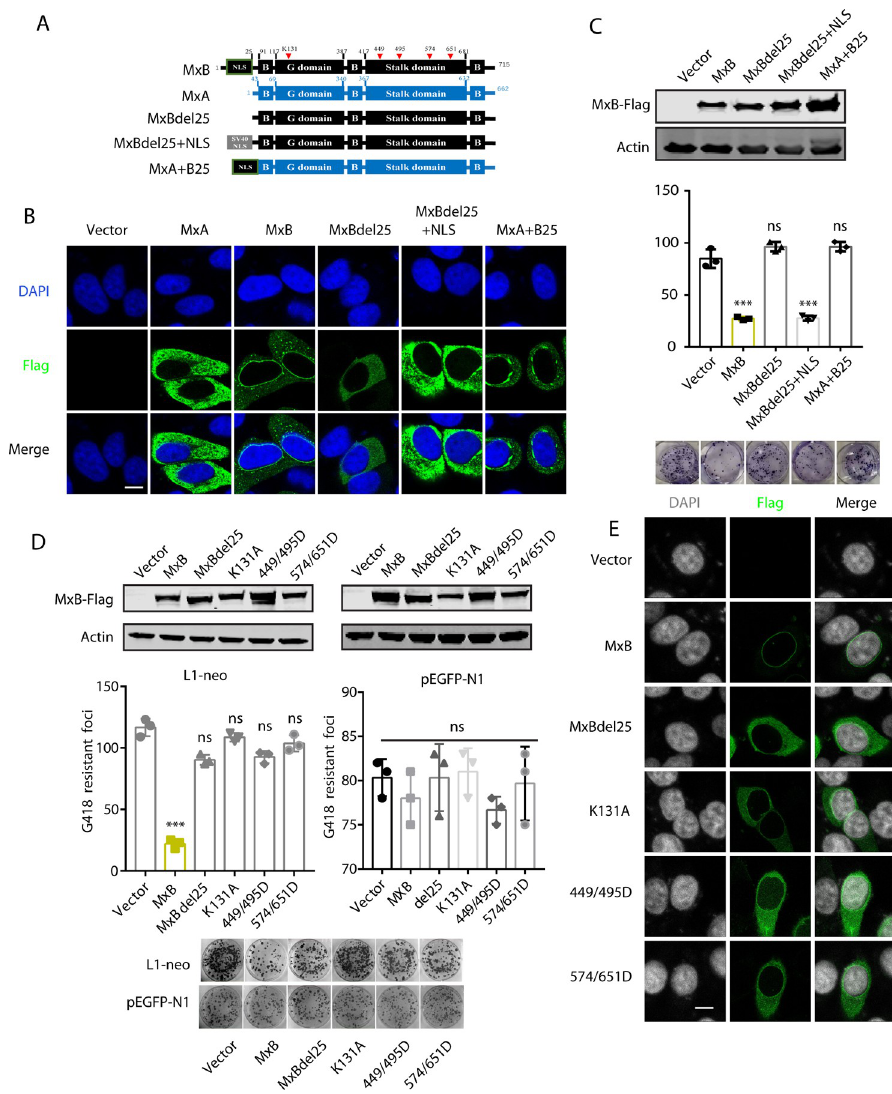
Fig 5. Effect of MxB mutations on the inhibition of LINE-1 retrotransposition. (A) Illustration of wild-type (WT) and mutated MxB proteins. NLS, nuclear localization signal; G domain, GTPase domain; B, bundle signaling element. (B) Subcellular localization of MxB and its mutants. (C) HeLa cells were co-transfected with CMV-L1-neo RT (250ng) and wild type MxB (250 ng) or its mutants, followed by G418 selection for resistant cell colonies. G418-resistant cell colonies were scored. The results of three independent experiments are presented in the bar graph (mean ± SEM; paired t -test). Expression of MxB and its mutants was determined by Western blot. (D) HeLa cells were co-transfected with CMV-L1-neo RT or pEGFP-N1 DNA and wild type MxB or the indicated MxB mutants. G418-resistant cell colonies were scored, the results of three independent experiments are presented in the bar graph (mean ± SEM; paired t -test). Expression of MxB and its mutants was determined by Western blot. �� , P < 0.01; ��� , P < 0.001. (E) MxB (500 ng DNA) or its mutants were transfected into HeLa cell. Their subcellular localization was detected by immunofluorescence staining. Bars represents 10 μ